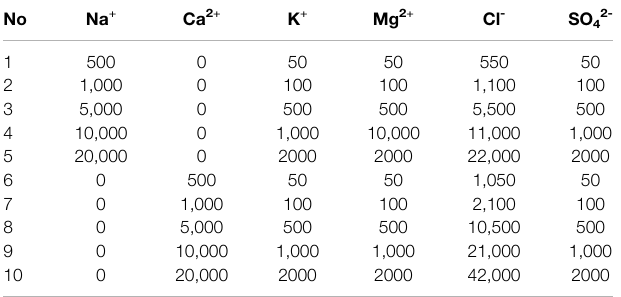
TABLE 1 | Composition of Na + and Ca 2+ Solutions (mg/L). TABLE 2 | Physical properties and components of crude